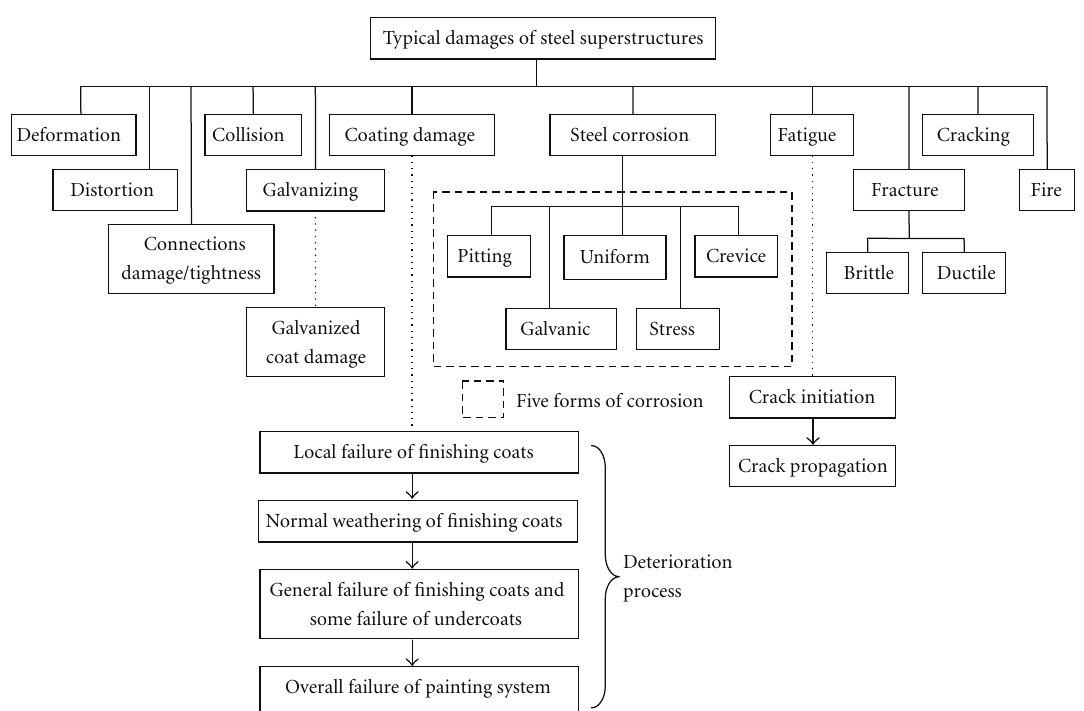
Figure 1: Typical types of damage of steel